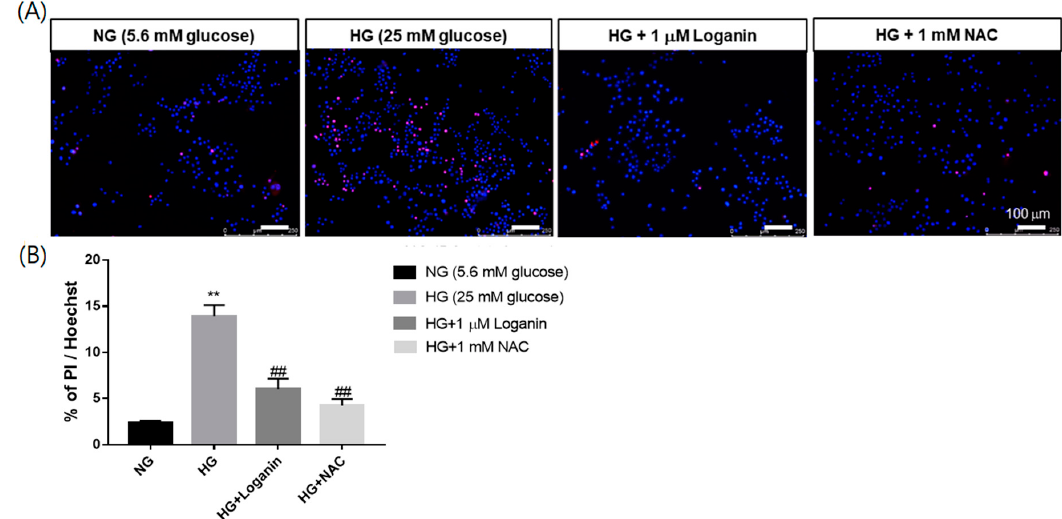
Figure 3. Effect of loganin on cell death in high-glucose-treated rat RSC96 Schwann cells by PI/Hoechst 33342 assay. RSC96 cells were pretreated with 1- μ M loganin or 1-mM N-acetylcysteine and incubated with 25-mM-high glucose (HG) for 48 h. ( A ) Representative composite images were acquired by fluorescence microscope (magnification, ×100; scale bar, 100 μ m). Dead cells were stained using PI and shown in red, and nuclei were stained with Hoechst 33342 (blue); ( B ) percentages of cell death were calculated by determining the ratio of PI-positive cells to Hoechst 33342-stained cells. Bars indicate mean ± SEM of the mean ( n = 6). ** p < 0.01 vs. NG group; ## p < 0.01 vs. HG group.